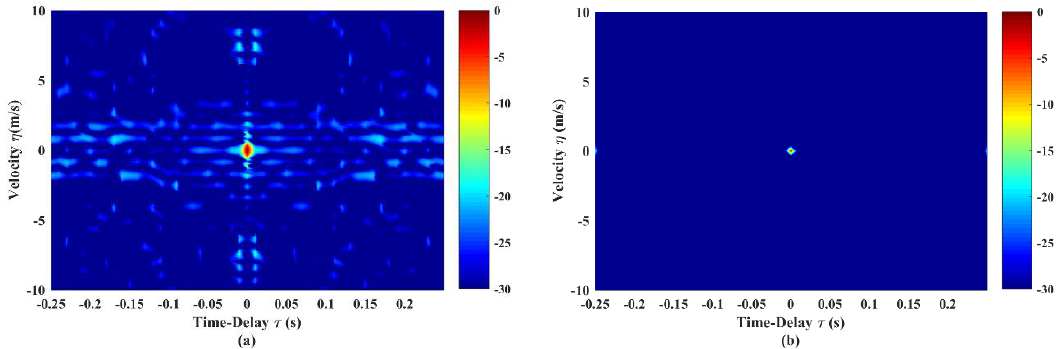
Figure 5. AF shapes of ( a ) GSFM pulse and ( b ) continuous pulse train ( N = 8) after optimization. The GSFM pulse in Figure 5a has the optimized parameters α = 1966, ρ = 2.21, and it composes the GSFM pulse train in Figure 5b.